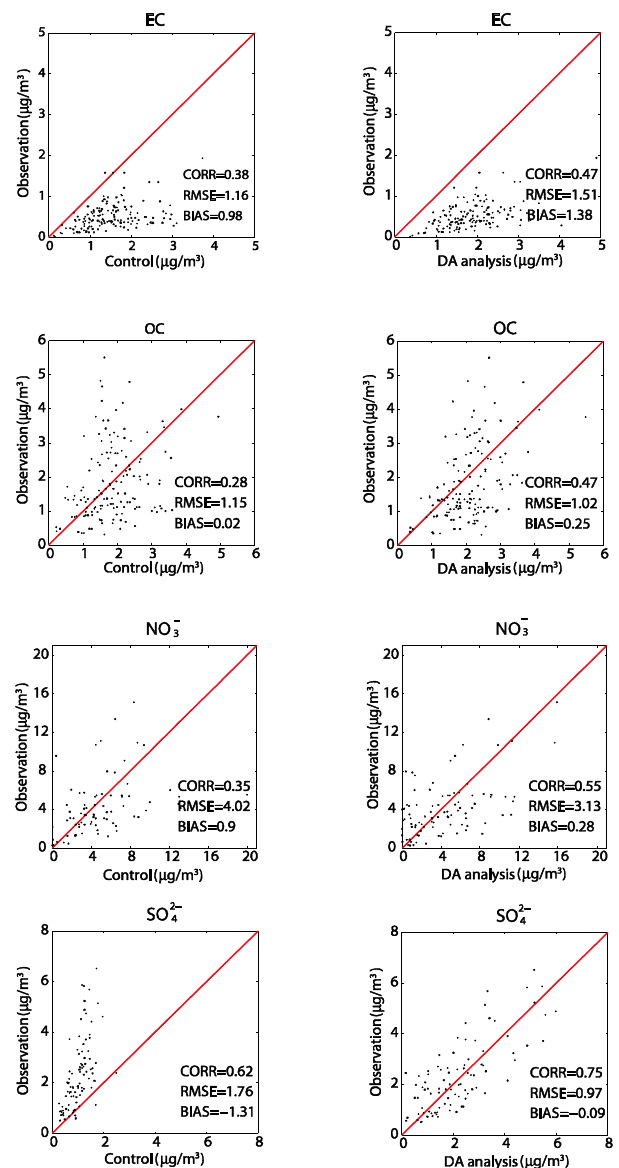
Figure 6. Scatter plots of model mass concentrations against observations with (left column) Fig. 6. Scatter plots of model mass concentrations against obser- vations without (left column) and with (right column) data assim- ilation for the species of EC, OC, NO − , and SO 2 − , respectively. and without (right column) data assimilation for the species of EC, OC, NO , and SO , 3 4 These observations are not assimilated and are, thus, independent data. These observations are obtained hourly from the super moni- respectively. These observations are not assimilated and are thus independent data. These toring station during the CalNex 2010 field observations are obtained hourly from the super monitoring station during the CalNex 2010 field experiment.